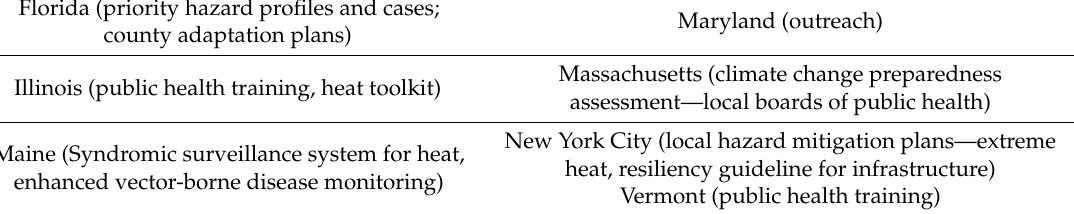
Examples of Other Adaptation Actions or Next Steps